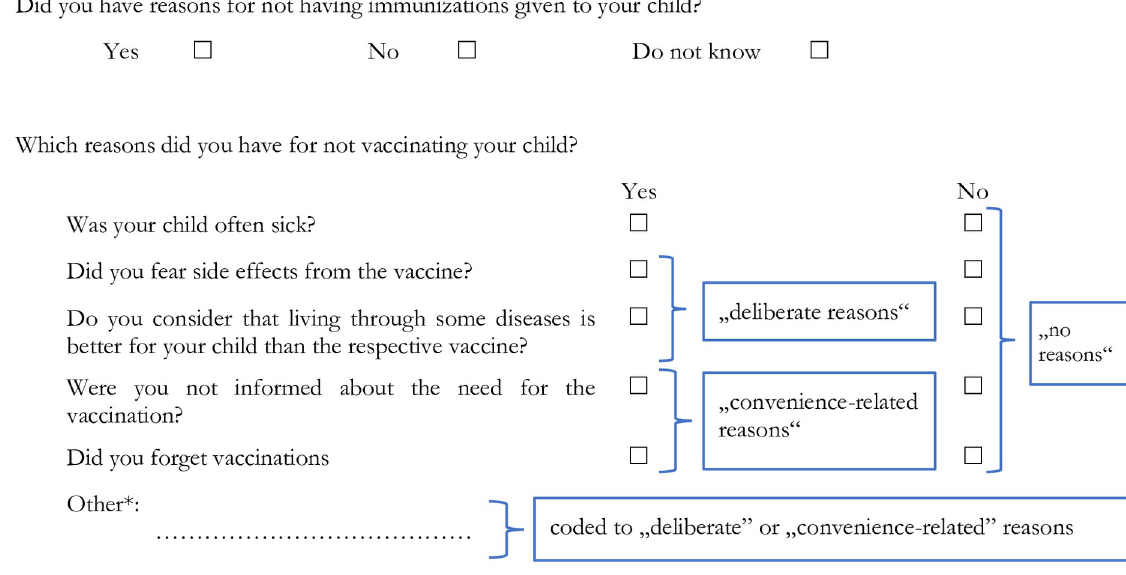
Fig 1. Survey instrument for reasons against vaccination. � See Table 1 for details on reasons reported in the open answer category, own translation of survey instrument (original question in German: Hatten Sie Gru¨nde, Ihrem Kind Impfungen nicht geben zu lassen?).